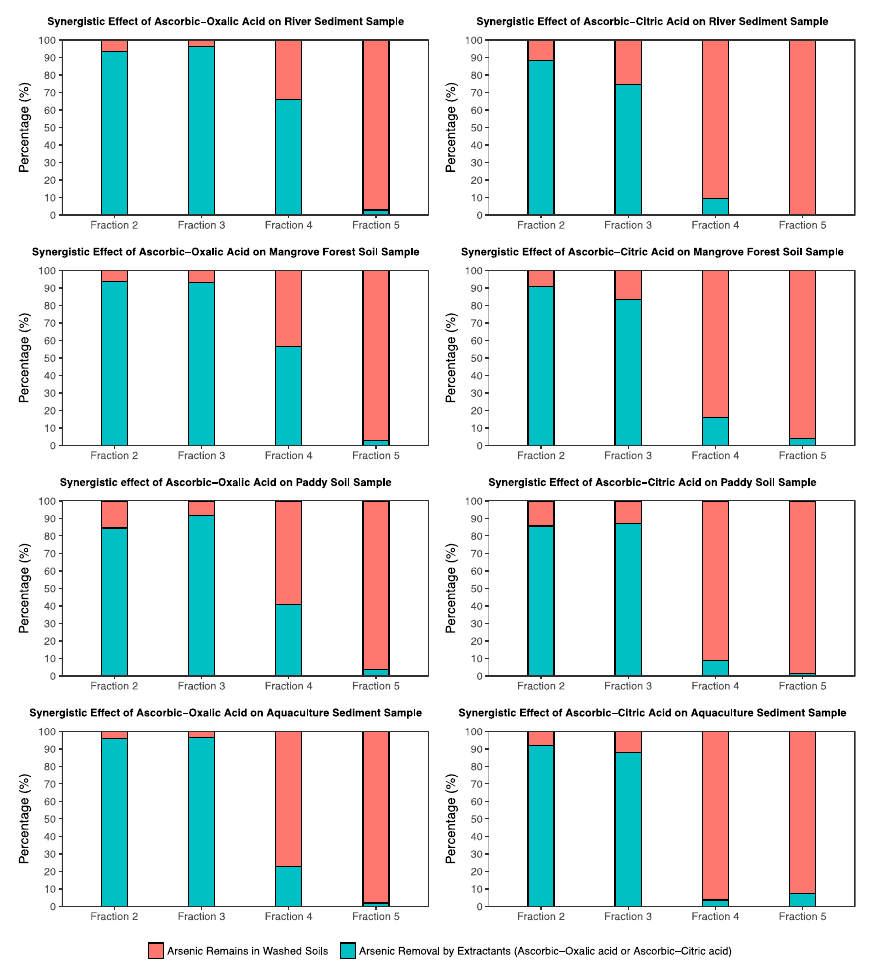
Figure 5. Percentages of arsenic removal and remnants in soils under the synergistic effect of ascorbic acid with each single solution of oxalic and citric